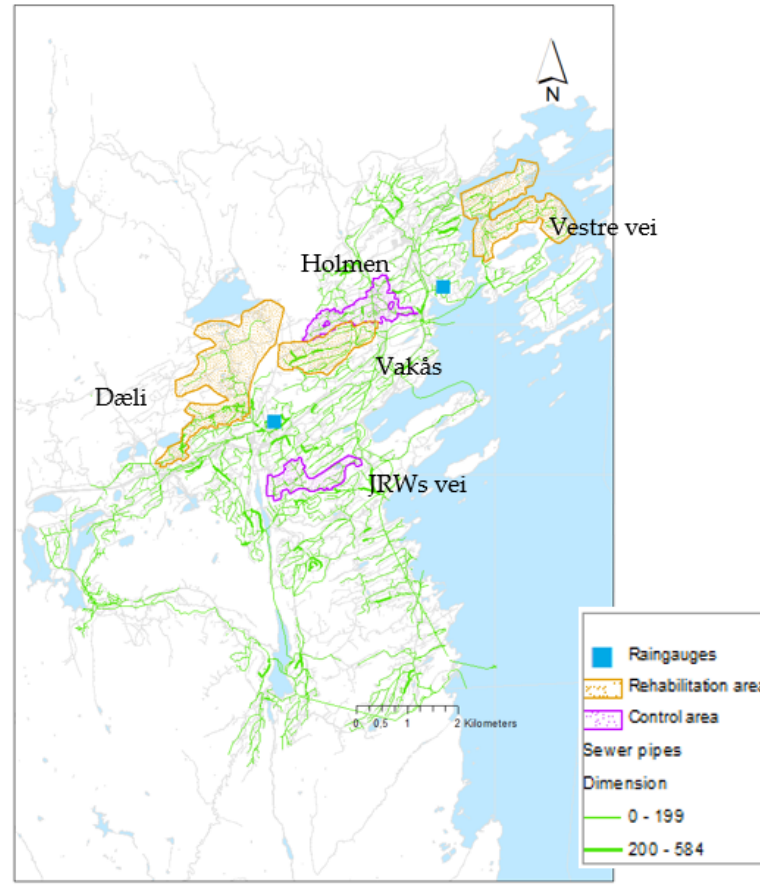
Figure 2. Overview map of the investigated areas as well as rain gauge locations.